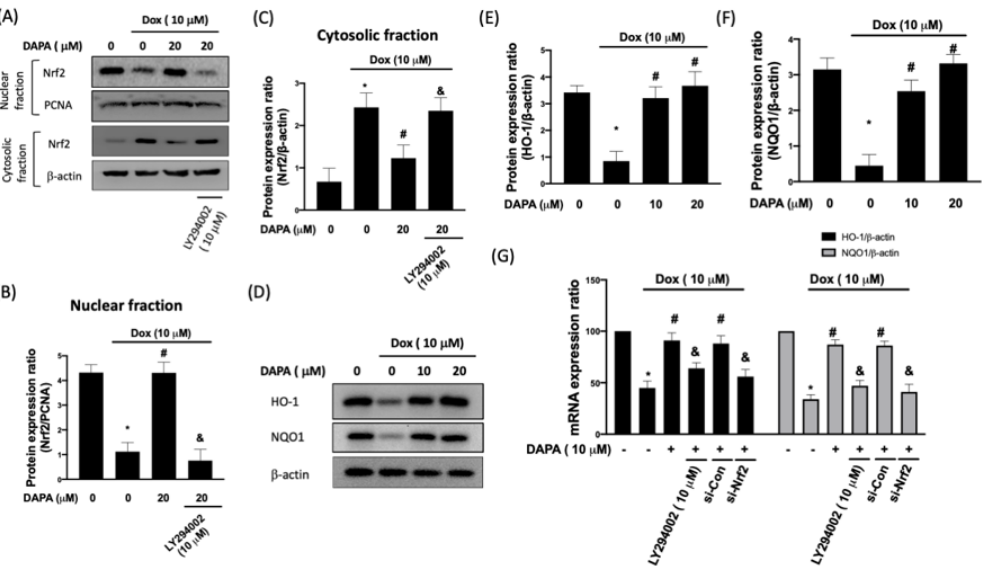
Figure 2. DAPA administration prevents the Dox-inhibited Nrf2 nuclear translocation and ex- pression of HO-1 and NQO1 . Western blot images ( A ), densitometric analysis of nuclear fraction ( B ), and cytosolic fraction ( C ) of Nrf2 in Dox-treated H9c2 cells were shown. Representative Western blot images ( D ), densitometric analysis of HO-1 ( E ) and NQO1 ( F ) in Dox-stimulated cells with or without DAPA treatment were revealed. Expression levels of HO-1 and NQO1 gene in Dox-treated cells with or without DAPA treatment were checked ( G ). LY294002 (a PI3K inhibitor) and si-Nrf2 were used in some experiments. Results are shown as means ± SD of three independent experiments. Statistical analysis was performed using one-way ANOVA with a Bonferroni post hoc test. [* p < 0.05 compared to the control group; # p < 0.05 compared to the Dox-only group; & p < 0.05 compared to Dox + DAPA group].